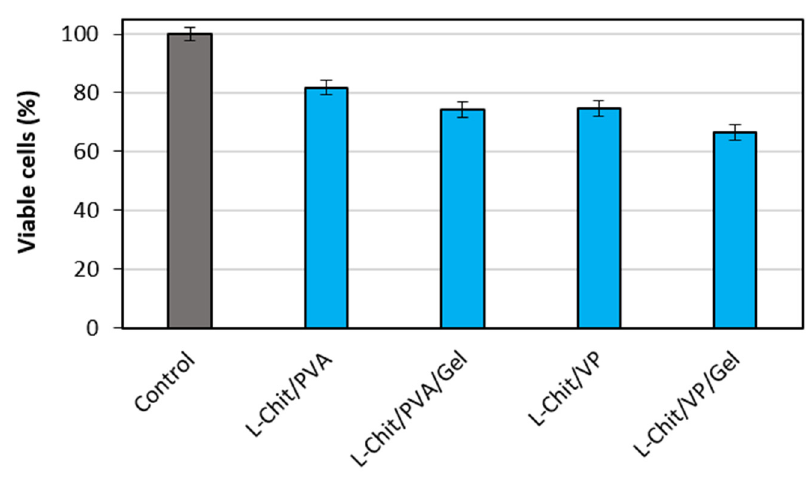
Figure 7. Viable HFFF2 cells growing in conditioned media by the respective membranes (blue bars) as a percentage of control cells (grey bar) growing in non-conditoned medium for 4 days ( n = 3; mean value ± SD).